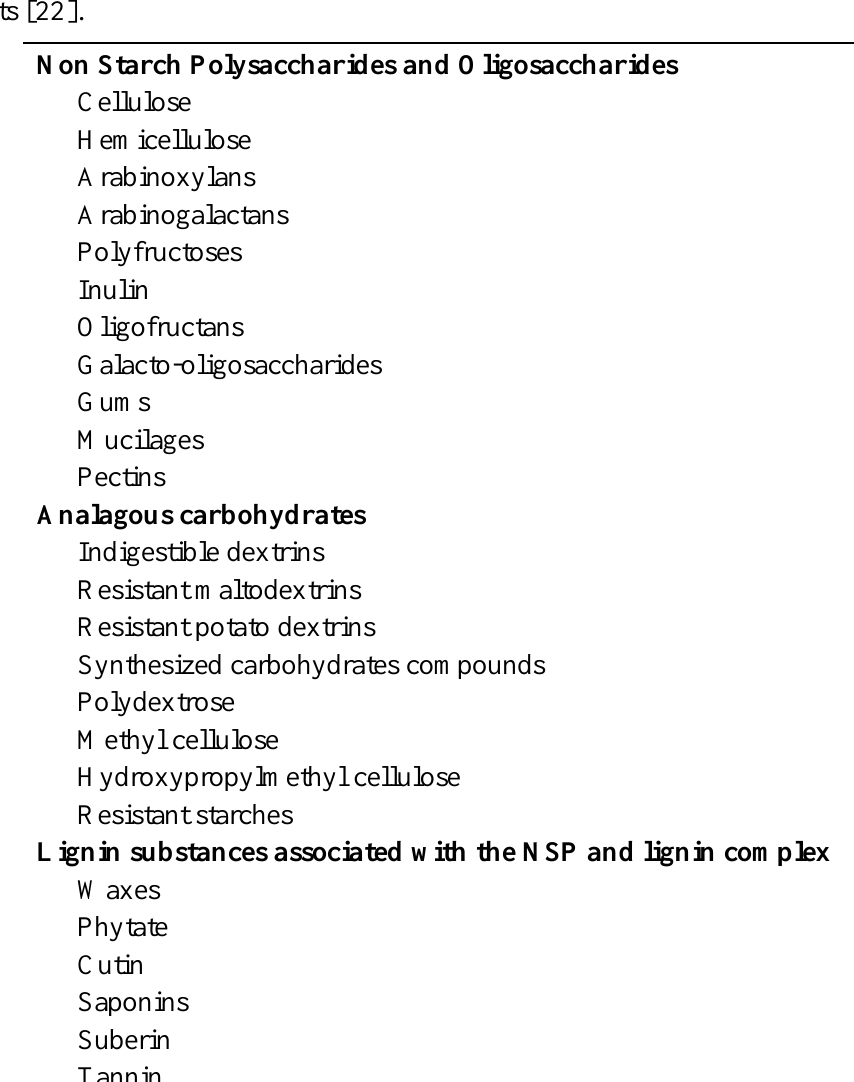
Table 1. Components of dietary fiber according to the American Association of Cereal Chemists